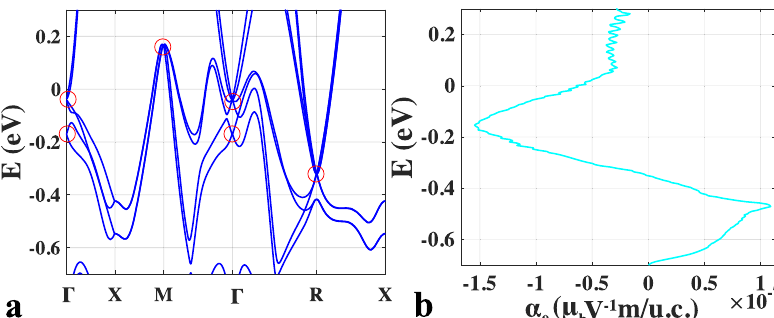
Fig. 3 The isotropic longitudinal magnetoelectric response in RhSn. a The band structure for RhSn. Both Kramers Weyl points as well as other multi-fold fermion band crossing points can be found. The red circles highlight the Kramers Weyl point as well as a four-fold fermion in the mateiral. b The isotropic longitudinal magnetoelectric susceptibility α 0 in units of μ b V − 1 m per unit cell is calculated. The effective scattering time is taken to be τ